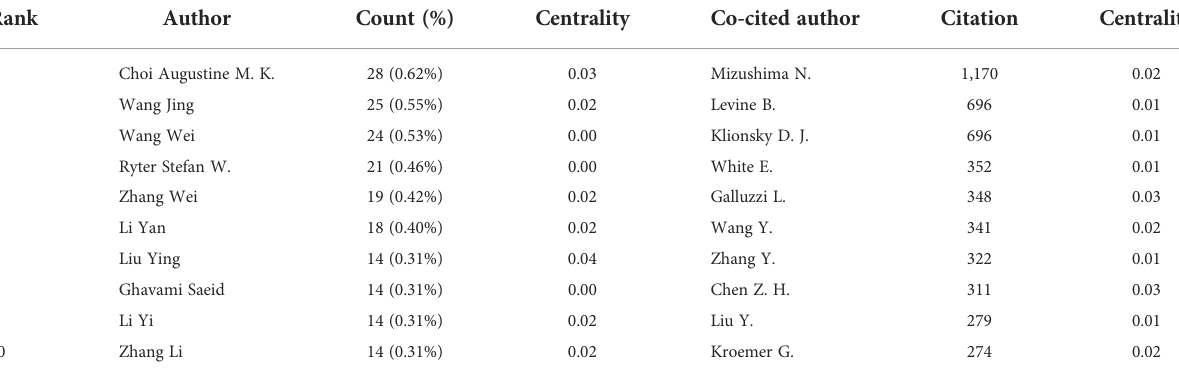
TABLE 2 Top 10 authors and co-cited authors related to autophagy in lung disease.